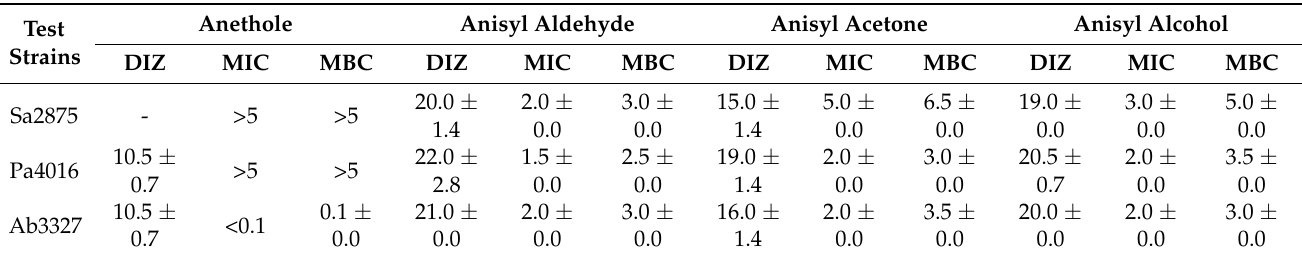
Table 4. Disk Inhibitory zone (DIZ, mm), minimum inhibitory concentrations (MIC, mg/mL) and minimum bactericide concentration (MBC, mg/mL) of the standard